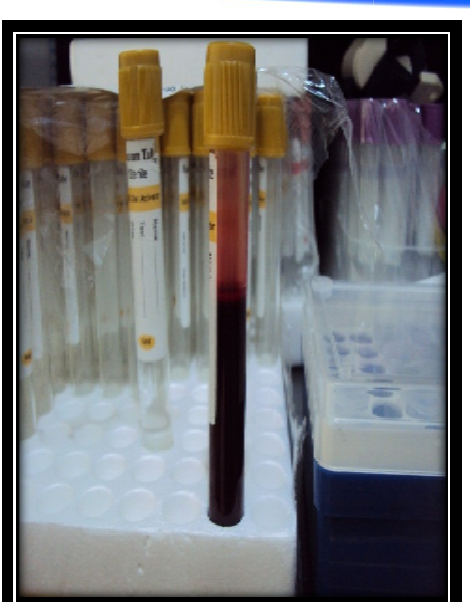
Figure Figure 1: Blood sample